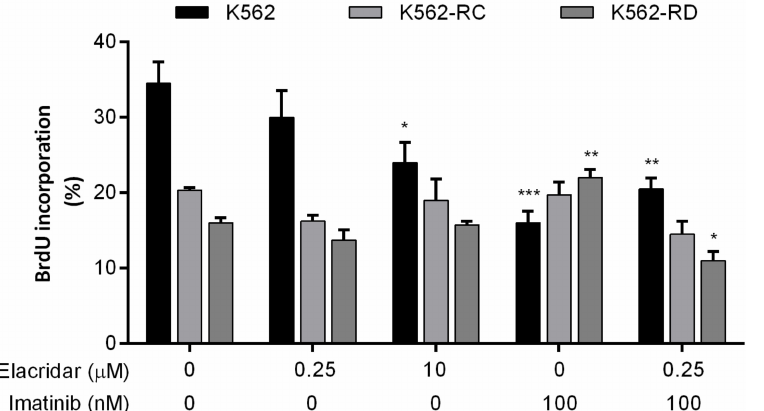
Figure 5. Effect of elacridar as monotherapy and in combination with imatinib on cell proliferation of CML cell lines. BrdU incorporation was evaluated to determine the cell proliferation rate of CML cell lines after each treatment, using Apoptosis, DNA damage, and Cell Proliferation kit for flow cytometry. Results were obtained after 48 h of incubation and represent mean ± SEM of at least four independent experiments. * p < 0.05; ** p < 0.01; *** p < 0.001 (comparison with control).